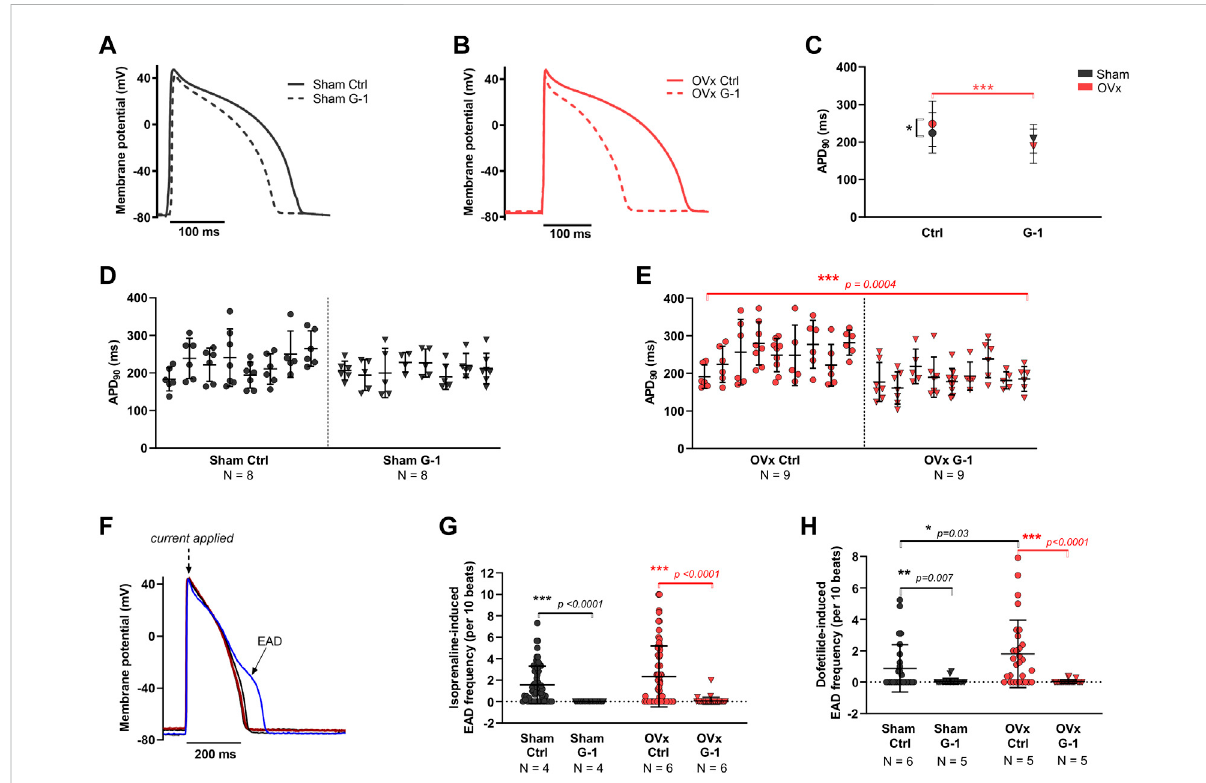
FIGURE 5 TheeffectofGPERontheactionpotential(AP)andabnormalmembranedepolarisations. (A) Typicalventricular APtracesfromsham±G-1and (B) fromOVx±G-1. (C) APD 90 prolongedinOVxcomparedwithshamandGPERactivationshortenedtheAPD 90 inOVxcells.Mean±95%CI.Nested t-test.* p < 0.05,*** p < 0.001. (D) NestedanalysesoftheeffectofGPERactivationonAPD 90 inshamand (E) OVxcardiomyocytes.Mean±SD.Nested t-test.*** p < 0.001,valueasindicated.Shamctrln/N=52/8,shamG-1n/N=46/8;OVxctrln/N=59/9,OVxG-1n/N=57/9. (F) Representative traces of cardiac action potential and early after depolarisation (EAD) formations. (G) Isoprenaline-induced EAD frequency decreased following GPERactivationinshamandOVx.Mean±SD.Student ’ st-test.*** p < 0.001,valuesasindicated.Shamctrln/N=65/4,shamG-1n/N=27/4;OVxctrl n/N = 65/6, OVx G-1 n/N = 39/6. (H) Dofetilide-induced EAD frequency reduced following GPER activation in sham and OVx. Mean ± SD.